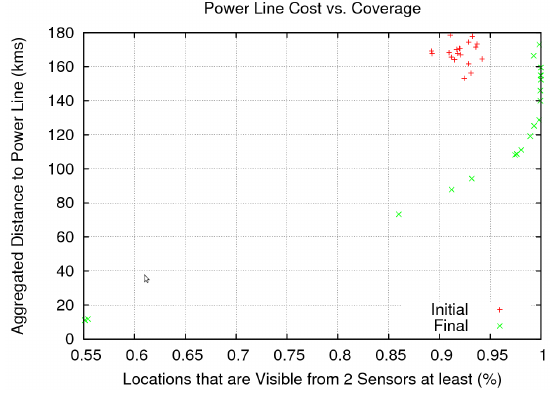
Figure 7. Aggregated distance to the power lines (cost) vs. coverage area with V ( x ) ≥ 2 .